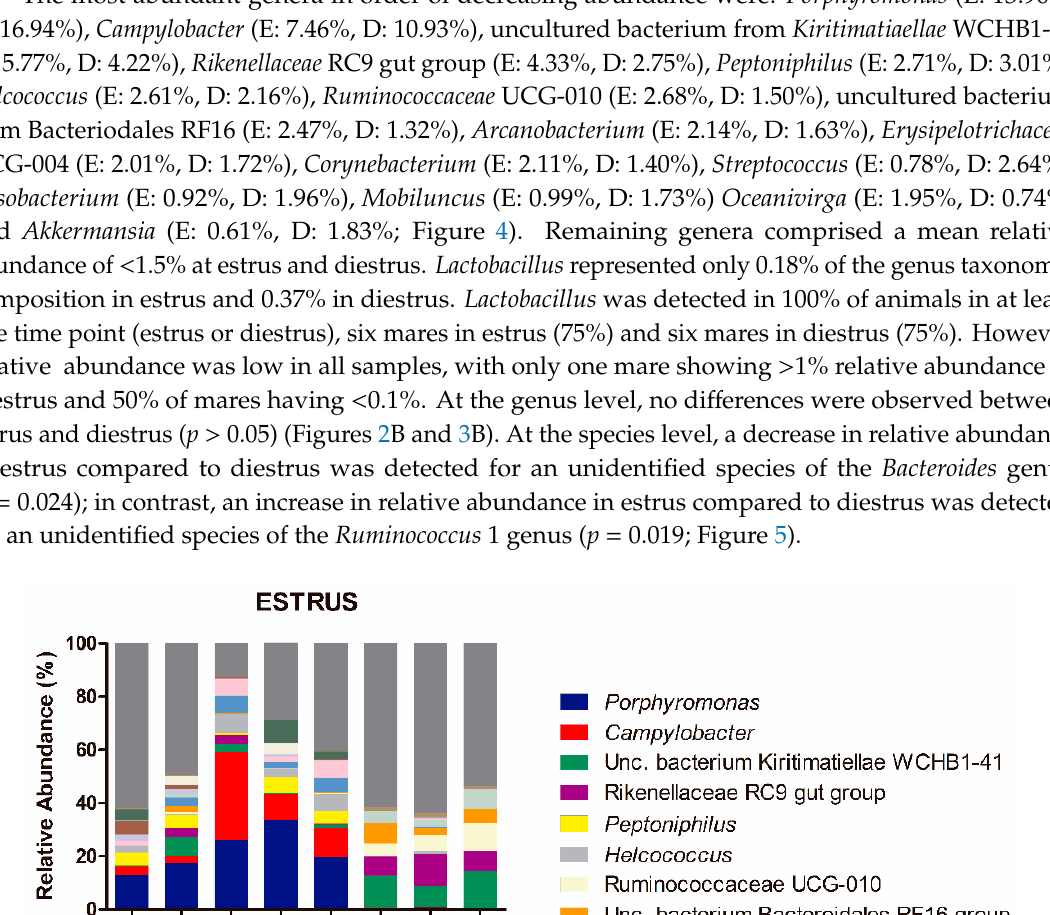
Figure 5. Differences in relative abundance of unidentified species of genera Bacteroides and Ruminococcus between estrus and diestrus in vaginal mare samples. Since no significant differences in the most abundant taxa between estrus and diestrus were identified, the mean relative abundance between estrus and diestrus of each mare was calculated to study the core vaginal microbiome. The core microbiome at the phylum level, consisted of Firmicutes (100%), Bacteroidetes (100%), Proteobacteria (100%) and Actinobacteria (87.5%). The core microbiome at the genus level consisted of Porphyromonas (87.5%), Campylobacter (100%), Arcanobacterium (87.5%), Corynebacterium (87.5%), Streptococcus (100%), Fusobacterium (87.5%), uncultured bacterium from Kiritimatiaellae WCHB1-41 (100%) and Akkermansia (87.5%).